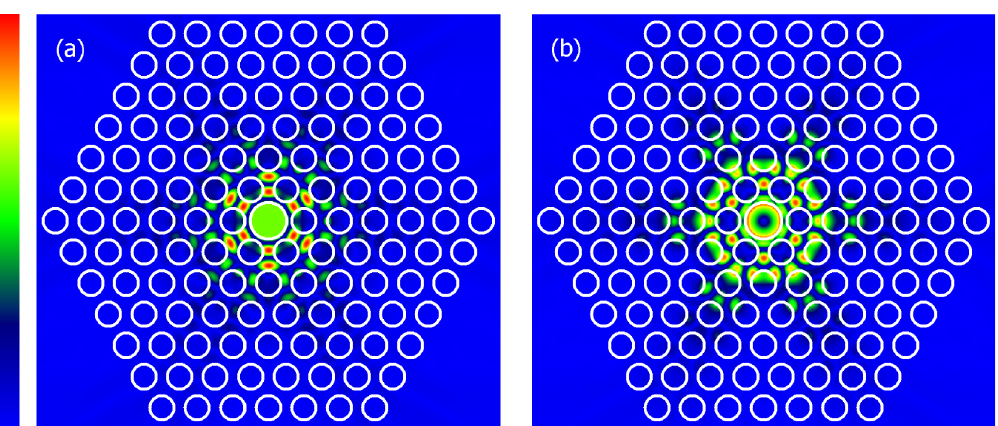
FIG. 3. (a) Longitudinal and (b) radial electric field intensity of the defect mode crossing the light line in the PBG fiber as calculated with the multipole method. The white circles indicate the hole boundaries. Note that a rainbow color scheme (the legend) is used to represent magnitude with the red and blue colors being the maximum and minimum, respectively. This color scheme will be used throughout the paper for color plots from the multipole